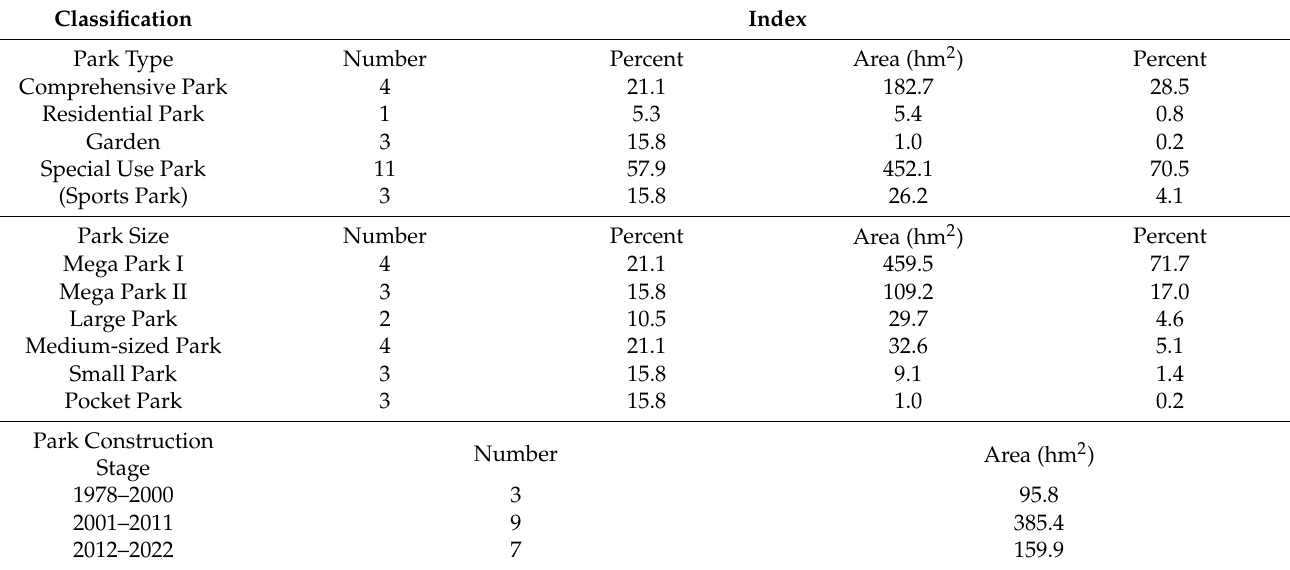
Table 1. Characteristics of the urban park system in